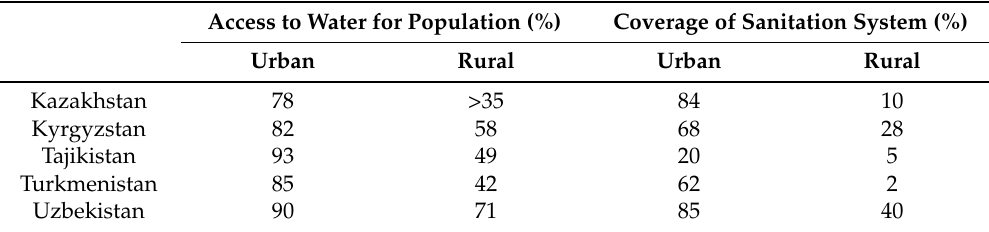
Table 2. Access to drinking water and sanitation in Central Asia (adapted from